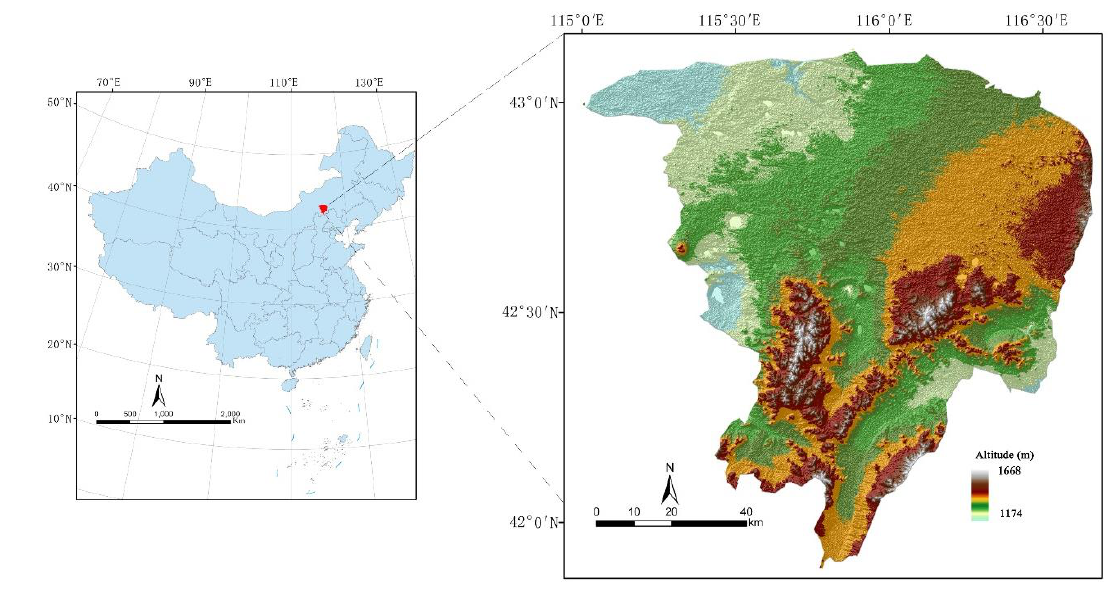
Figure 2. Location and topographic map of the Zhenglan Banner.